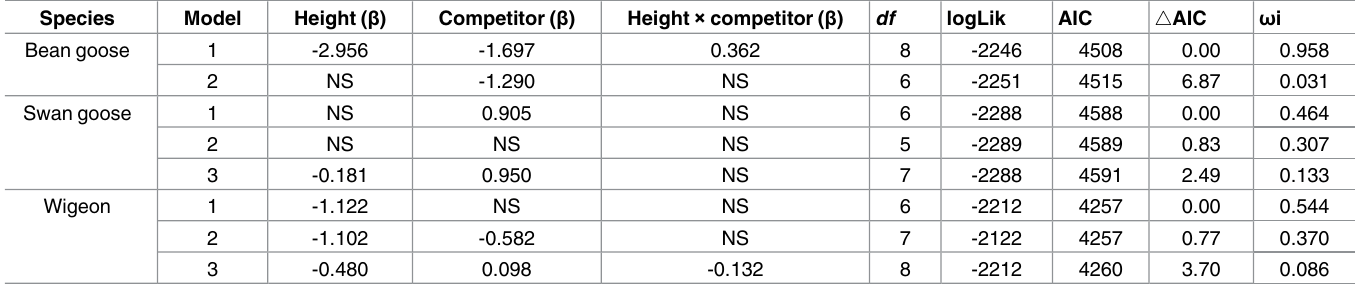
Table 5. Results of the best GLMMs to test whether the peck rate was affected by sward height and competitors. In the model sward height, com- petitor and their interaction term were included as fixed factors, whereas session, enclosurenumber, and individualwere always included as random factors in all models. NS indicates that the parameter was not included in the model. All models with 4 AIC < 2, and the next best model are reported (AIC = Akaike Information Criterion. df ; logLik, 4 AIC = AIC(i)—AIC(min); ω i = Akaike weights).